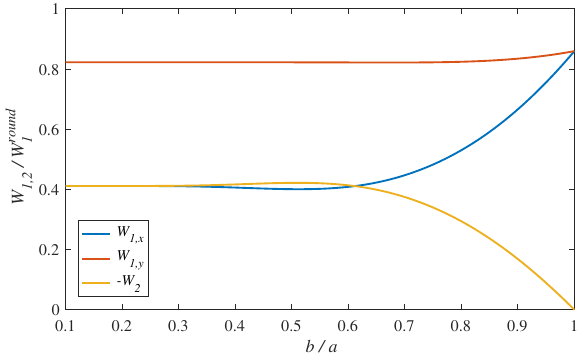
FIG. 15. Coefficients of the wake function versus the ratio of chamber height to chamber width. The coefficients are normal- ized with W round 1 , the wake function when chamber is round and the radius equals b